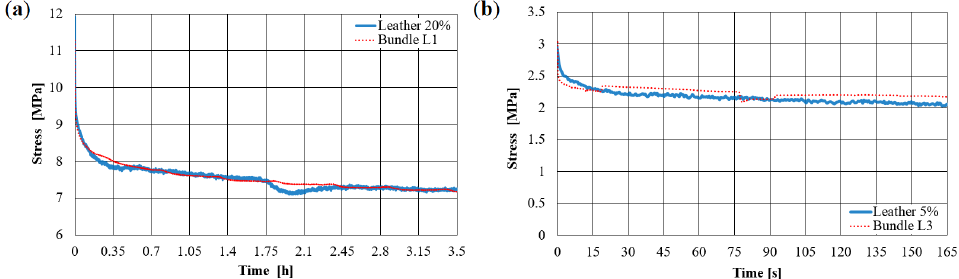
Figure 19. Comparison of relaxation curves calculated from fiber-bundle properties and from CT images (red curves) with relaxation tests for leather samples (blue curves): ( a ) Simmental breed L1 and ( b ) zebu